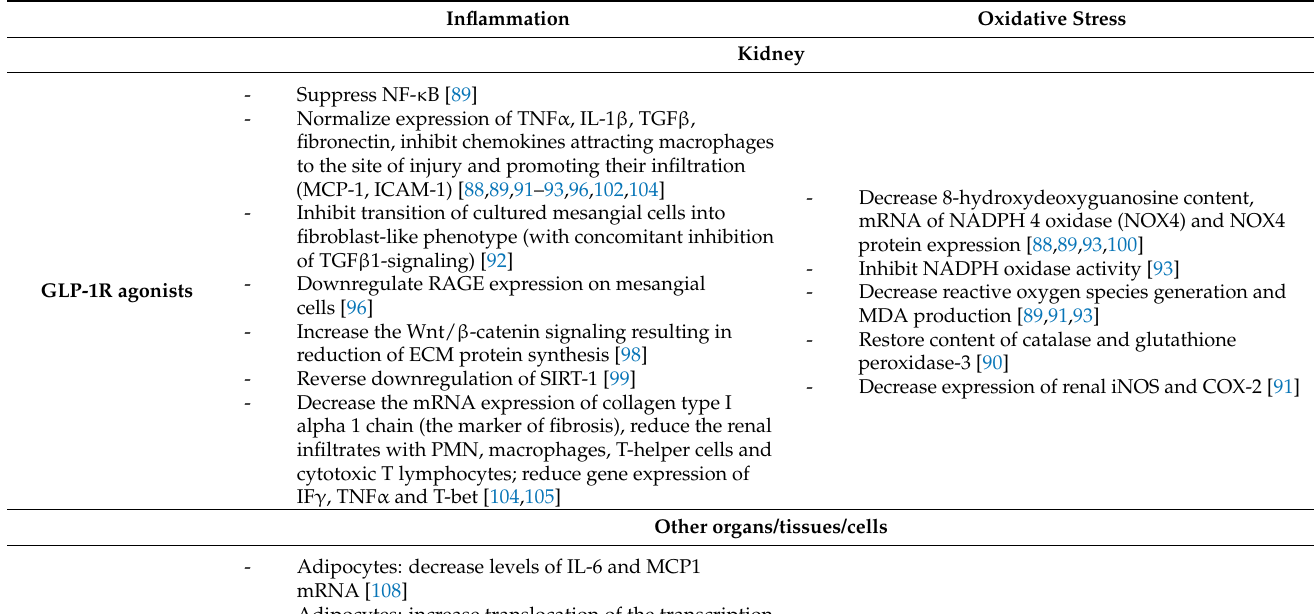
Table 2. Selected mechanisms of interactions between GLP-1R agonists, inflammation and oxidative